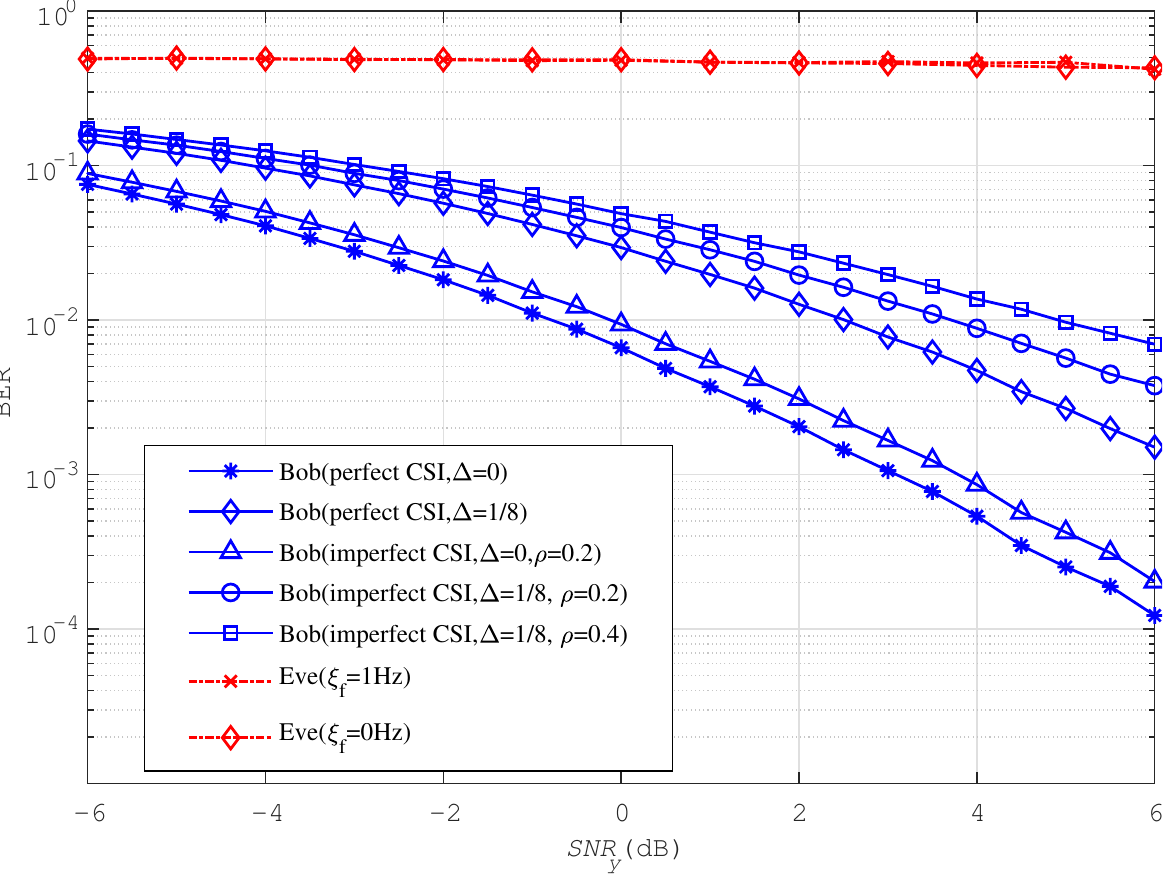
Figure 10. BER performance of Bob and Eve over fading channel for D = 5 and N =